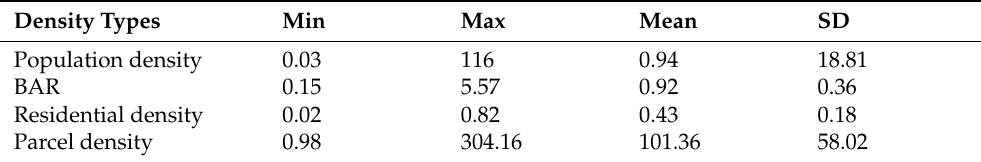
Table 2. Descriptive statistics of densification in all zones of Shiraz (2016).